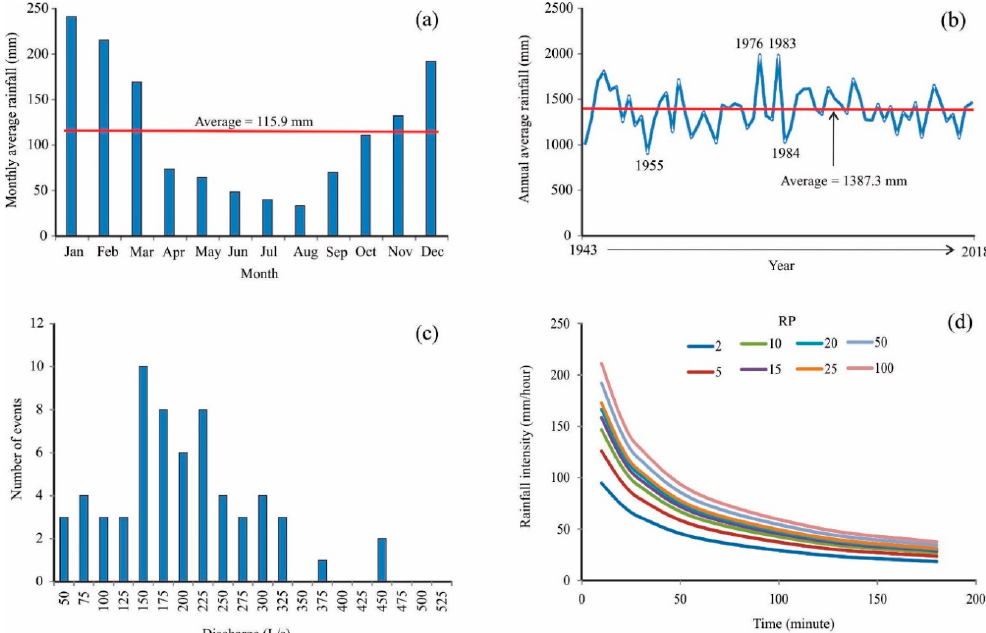
Figure 2. Rainfall data for the catchment area. ( a , b ) Monthly ( a ) and annual ( b ) averages rainfall; ( c ) frequency of discharge for a 73-year period (1944–2017) in the Itaim Stream catchment (DAEE); ( d ) rainfall intensity with different return periods (RP) in the Itaim Stream catchment. Graphs made by the authors based on raw data available on DAEE database.